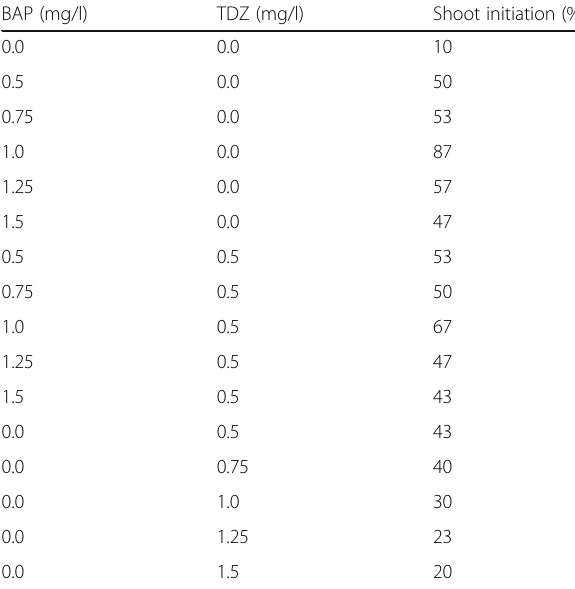
Table 3 Effect of different concentrations of BAP in combination with TDZ on shoot initiation of S. longipedunculata